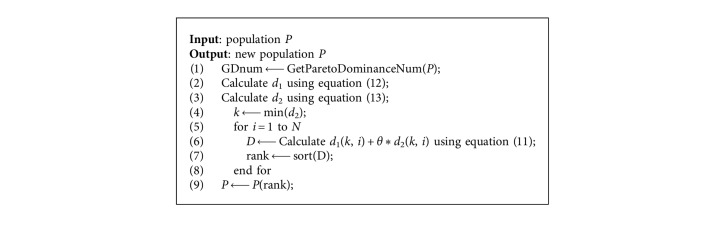

θ-dominance sorting.